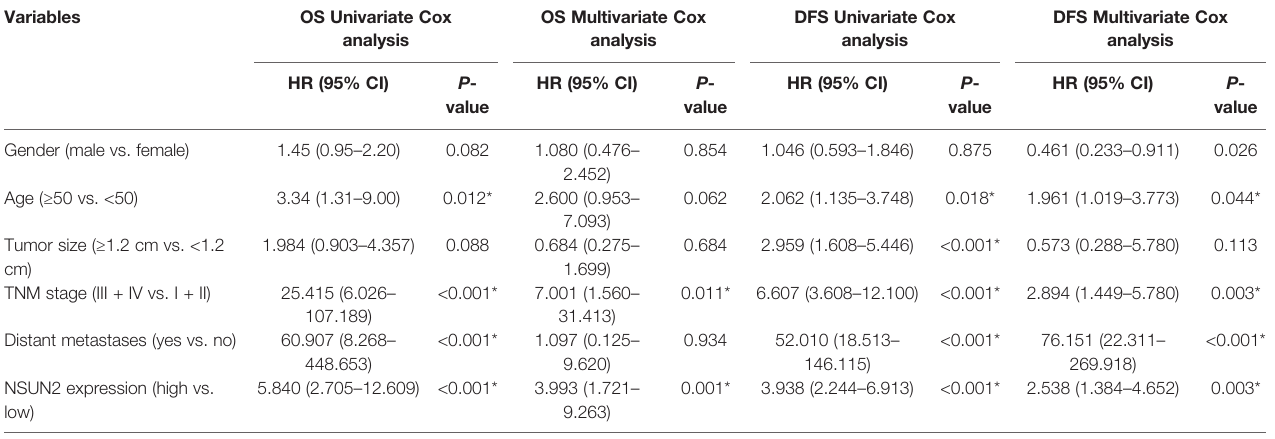
TABLE 2 | Univariate and multivariate Cox regression analyses of overall survival in patients with NPC. Variables